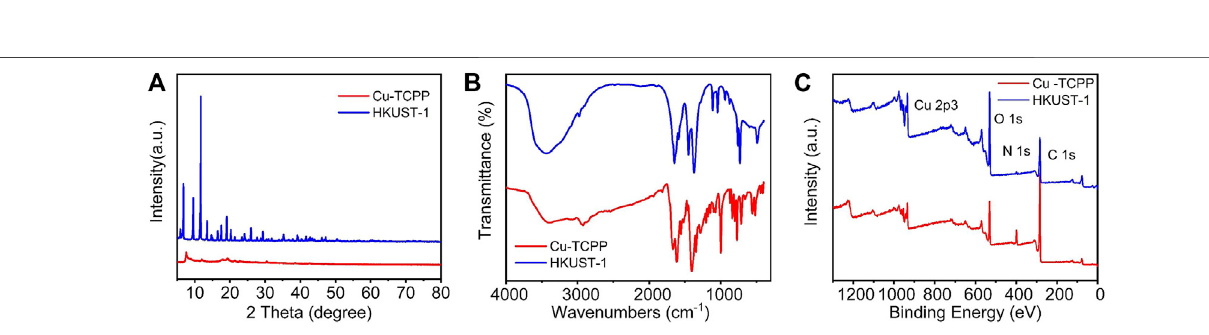
FIGURE 2 | (A) XRD pattern of Cu-TCPP and HKUST-1. (B) FT-IR pattern of Cu-TCPP and HKUST-1. (C) XPS pattern of Cu-TCPP and